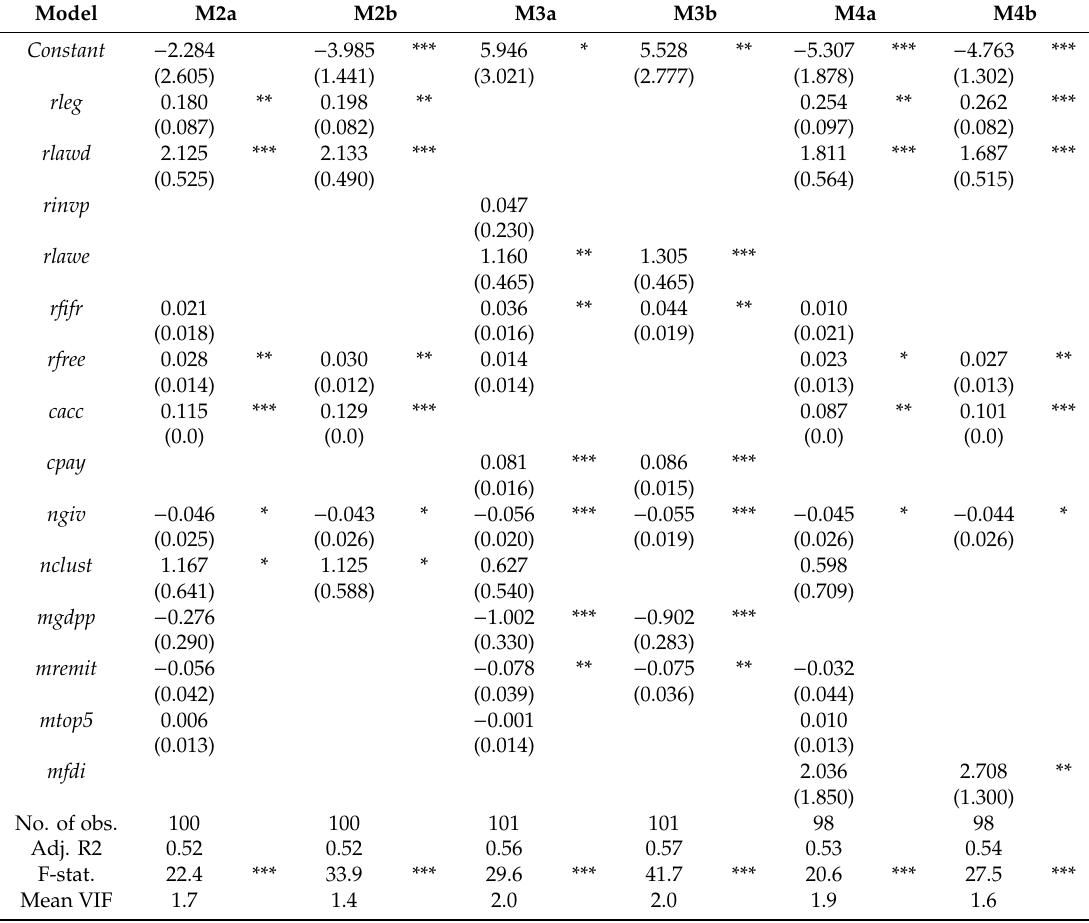
Table 5. Institutional determinants of total crowdfunding volumes during 2015–2016 per